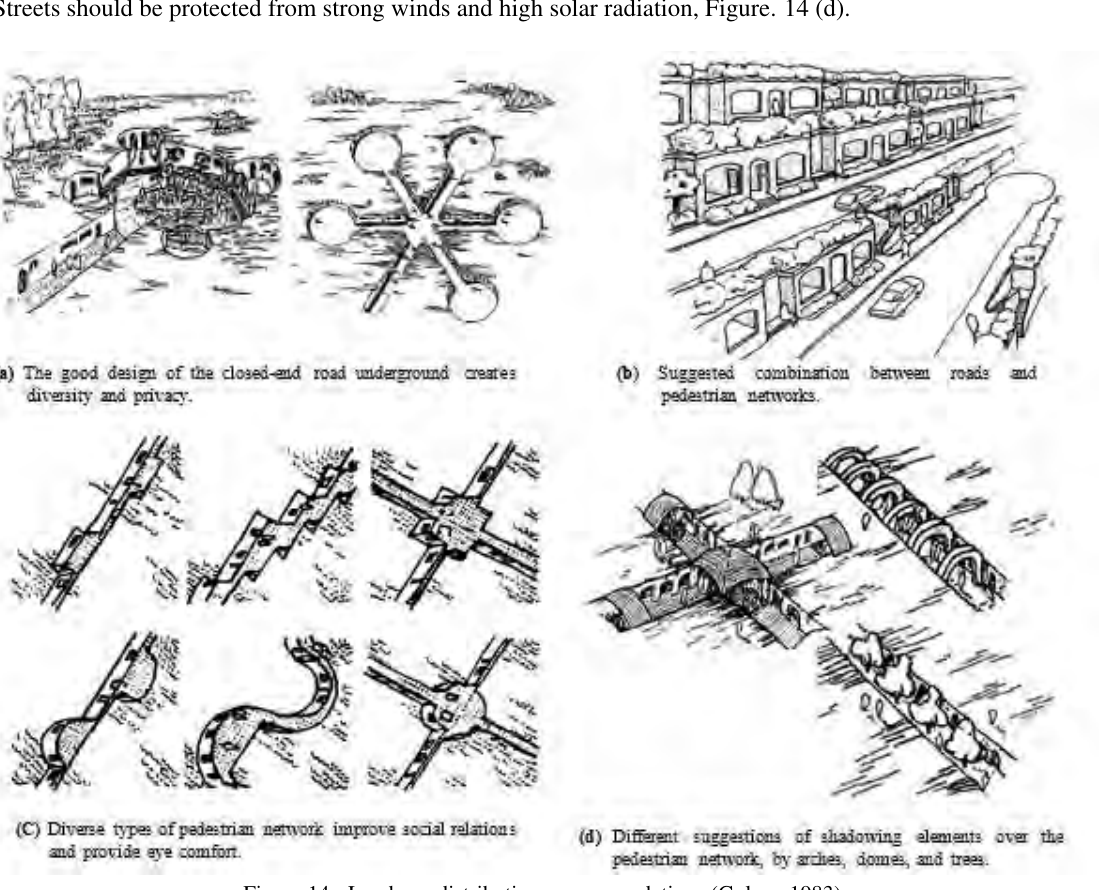
Figure 14. Land-use distribution recommendations (Golany